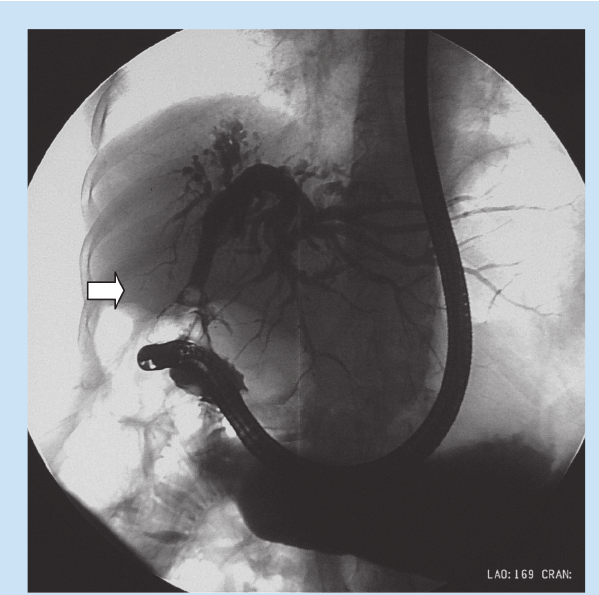
Fig. 3. ERCP image (LAO view) demonstrating a stone impacted in the common bile duct (white arrow) in the same patient.